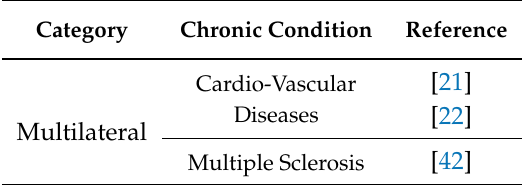
Table 5. Multilateral combination category category chosen